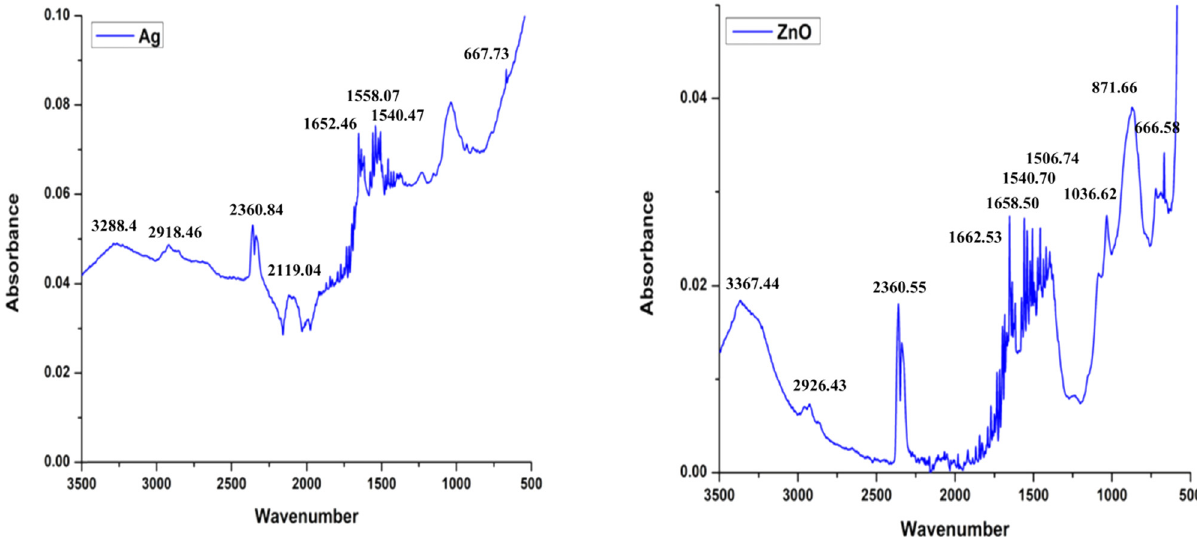
Figure 5: FTIR spectra of Ag - NPs and ZnO -